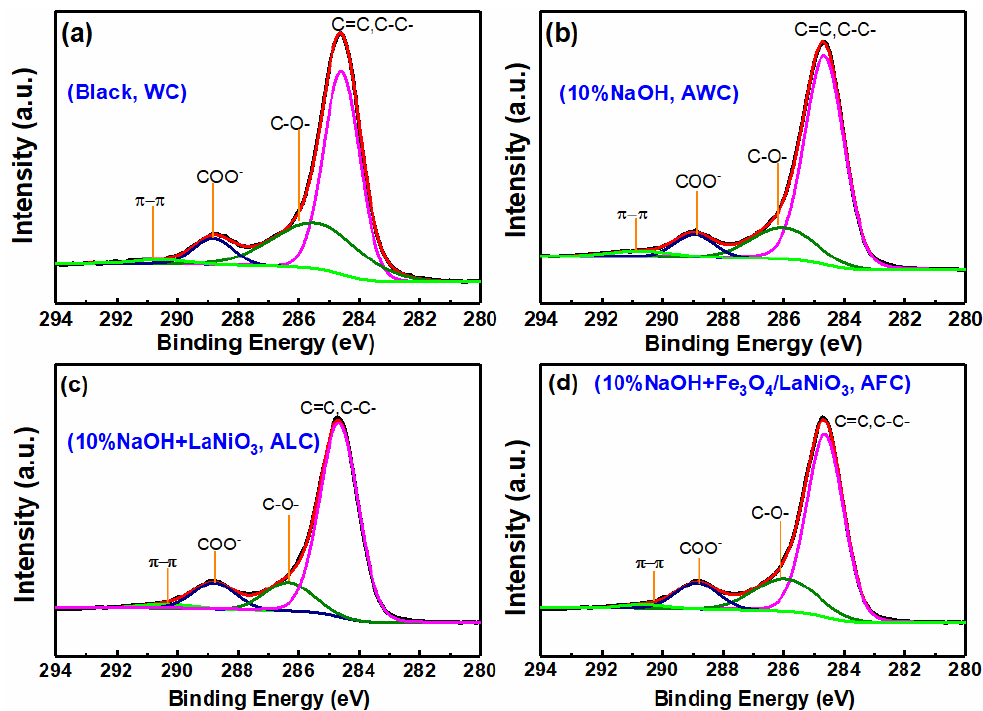
Figure 6. XPS C1s spectra of four different treatments of humic acid ( a ) WC, ( b ) AWC, ( c ) ALC, and ( d ) AFC. Table 2. Relative distribution of carbon functional groups in weathered coal humic acid determined by